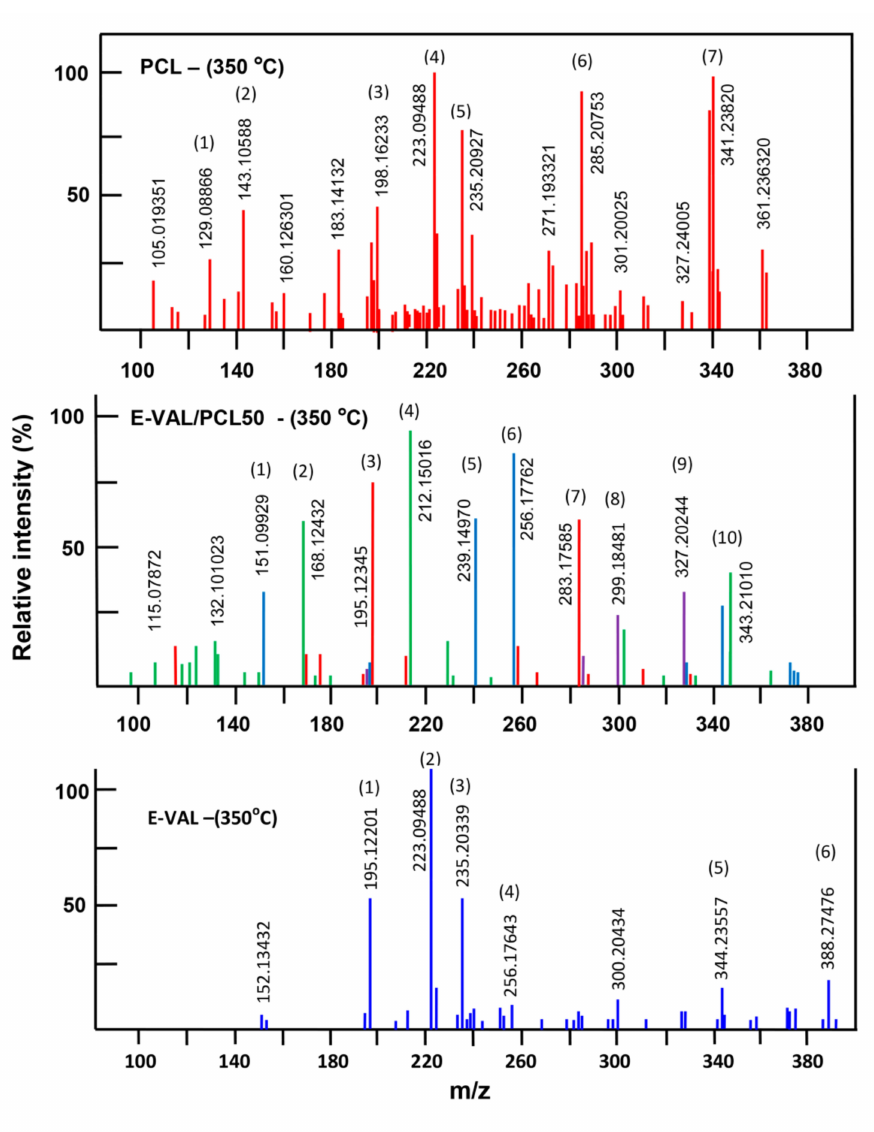
Figure 9. The spectra of the isothermal decompositions of the blends and their pure components, as obtained by DART-ToF-MS at 350 ◦ C. Table 5. Principal fragments obtained by the isothermic decomposition of pure E-VAL. N